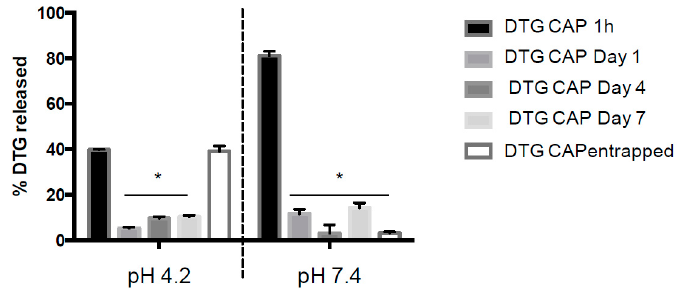
Figure 2. Percent of Entrapped DTG Released from DTG–CAP–NP. In vitro and HPLC analysis of DTG release from DTG–CAP–NPs over a one-week time at pH 4.2 and pH 7.4. DTG–CAP entrapped represents the amount of DTG remaining entrapped in the NP at the end of the one-week experiment. Error bars represent standard error of mean (SEM). * p < 0.05.